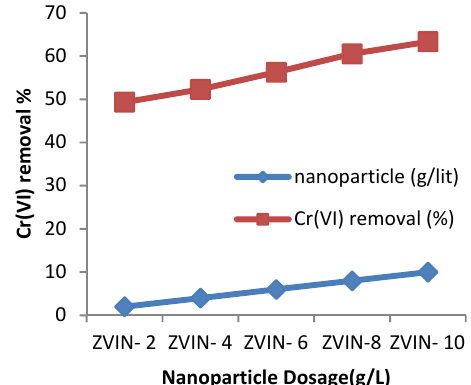
Fig.3.The removal efficiency of Cr(VI) using bare ZVINs as a function of ZVINs Fig.3.